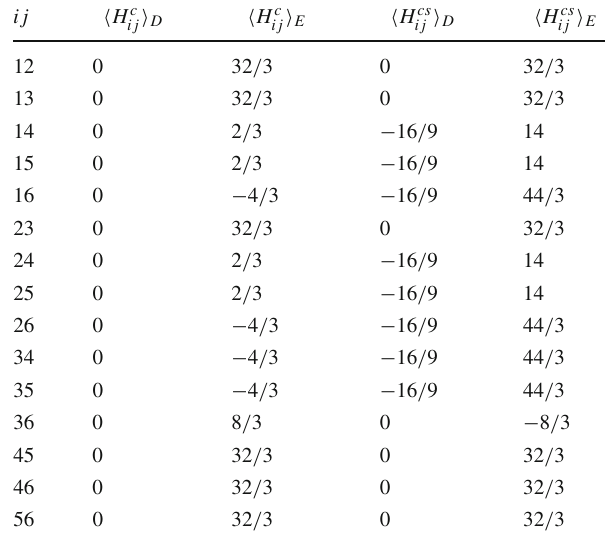
Table 7 The matrix elements in spin-flavor-color-isospin spaces of the color-singlet channel for the Ω ccc Ω ccc system with J P = 0 +